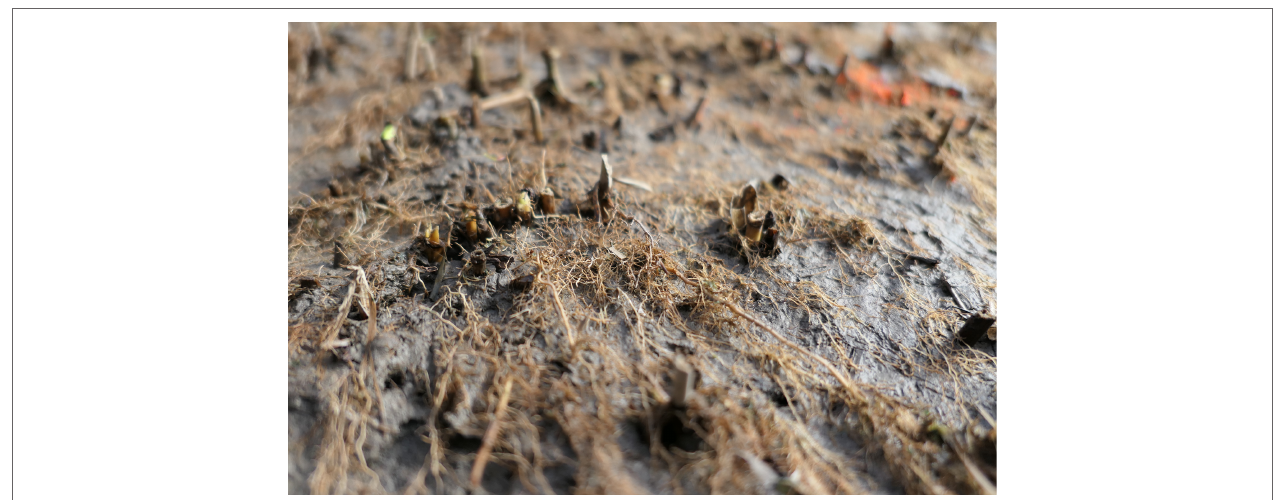
FIGURE 8 | Sediment surface after the last experimental run with the emerging shallow subsurface mat of fine roots. Note that above-ground shoots have been manually